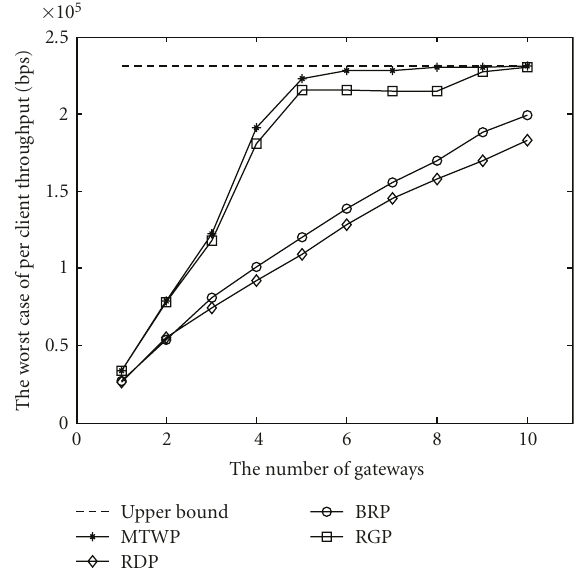
Figure 9: The aggregate throughput by changing the number of gateways with di ff erent channel capacity of mesh routers.